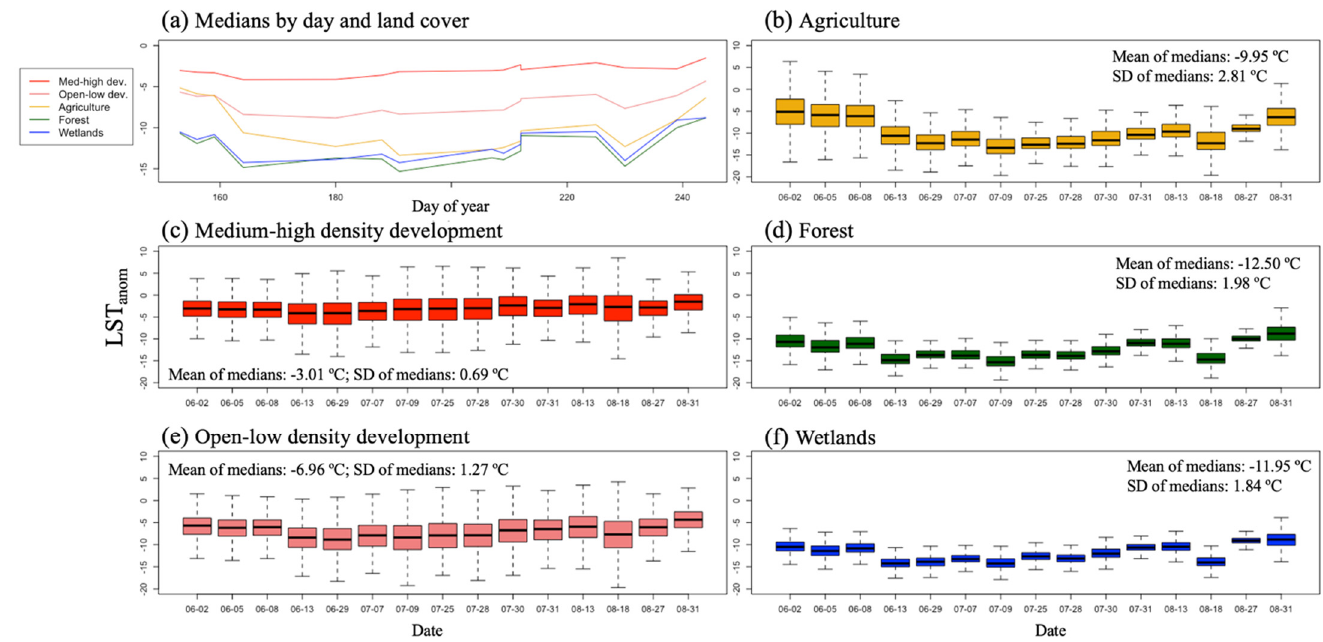
Figure 7. ( a ) Dane County median LST anom by day of year across five land cover categories and ( b – f ) boxplots of LST anom by date for each individual category. Each box plot indicates the interquartile range (IQR), with the edges marking the first (Q1) and third (Q3) quartiles, the central black line indicating the medians, and the upper and lower whiskers indicating the LST anom values equal to Q3 + 1.5 * IQR and Q1 − 1.5 * IQR, respectively.